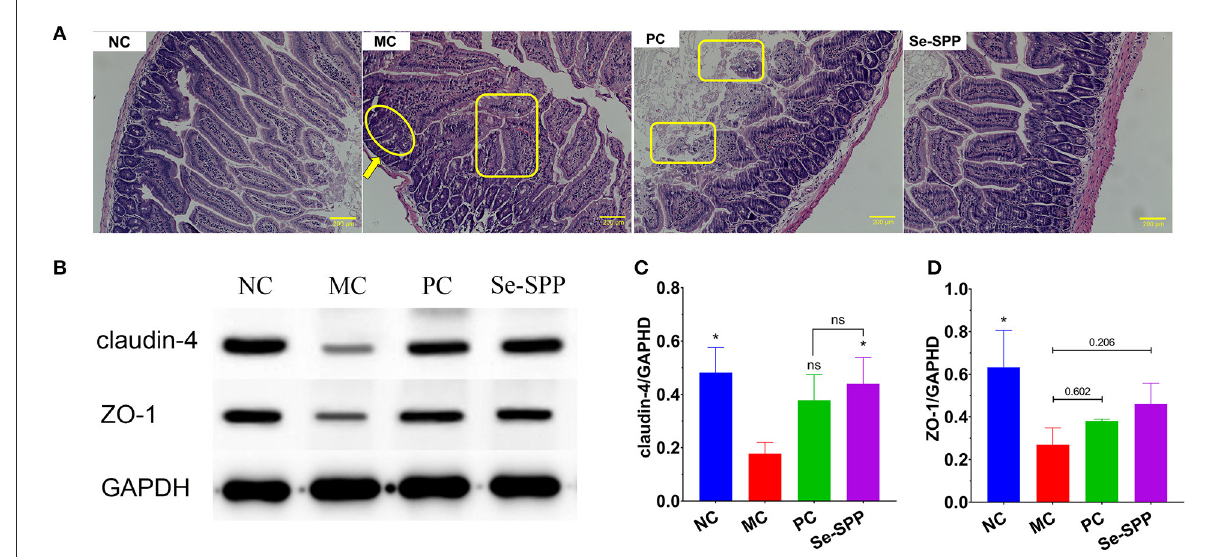
FIGURE3 Se-SPP prevents Cd-induced the disruption of the intestinal barrier in mice. Images of the H&E-stained jejunum [ (A) , 20 × ]; thinned of muscularis (arrow); fusion or disappearance of villi (circle); disorders in epithelial cells (rectangle). Analysis of tight junctions (TJ) proteins using Western blots (B–D) . NC, normal control; MC, model control; PC, positive control; Se-SPP, selenium-containing polysaccharides from Spirulina platensis . Data are expressed as mean ± SEM ( n = 3). Graph bars marked with ns: not significant,* p < 0.05, ** p < 0.01, *** p < 0.001, when compared with